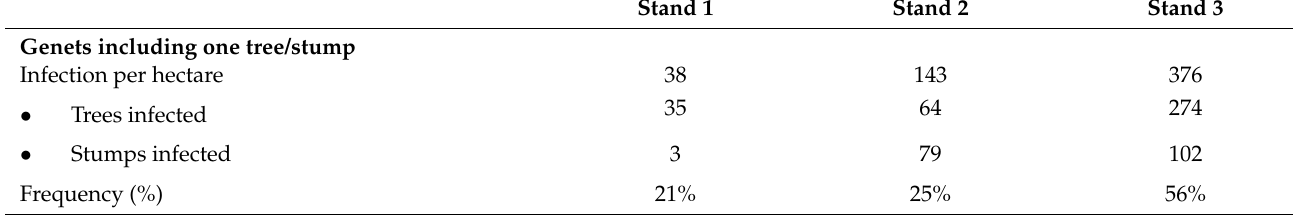
Table 4. Distribution pattern and characteristics of Heterobasidion parviporum genets in disease centres of managed Norway spruce stands on former pasture and meadows. Stand 1 Stand 2 Stand 3 38 143